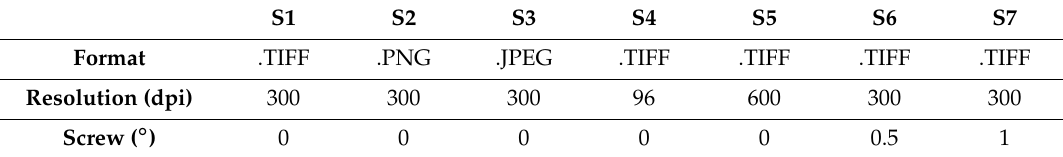
Figure 1. Creation of digital cardiotocographic (CTG) images and extraction of CTG signals. Original CTG signals from the ‘CTU-UHB Intrapartum Cardiotocography Database’ are plotted on a CTG grid and saved according to features (format, resolution and screw) chosen by the user. The obtained digital CTG images are submitted to eCTG in order to get the extracted CTG signals. Table 1. Features (format, resolution and screw) associated to each set of images.